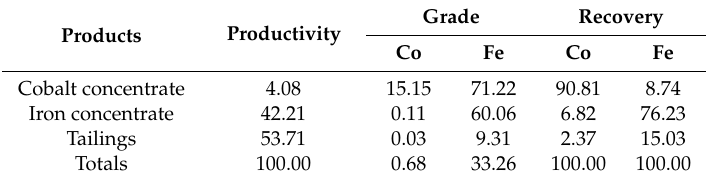
Table 7. Results of oxidizing roasting–segregation roasting–magnetic separation (%).